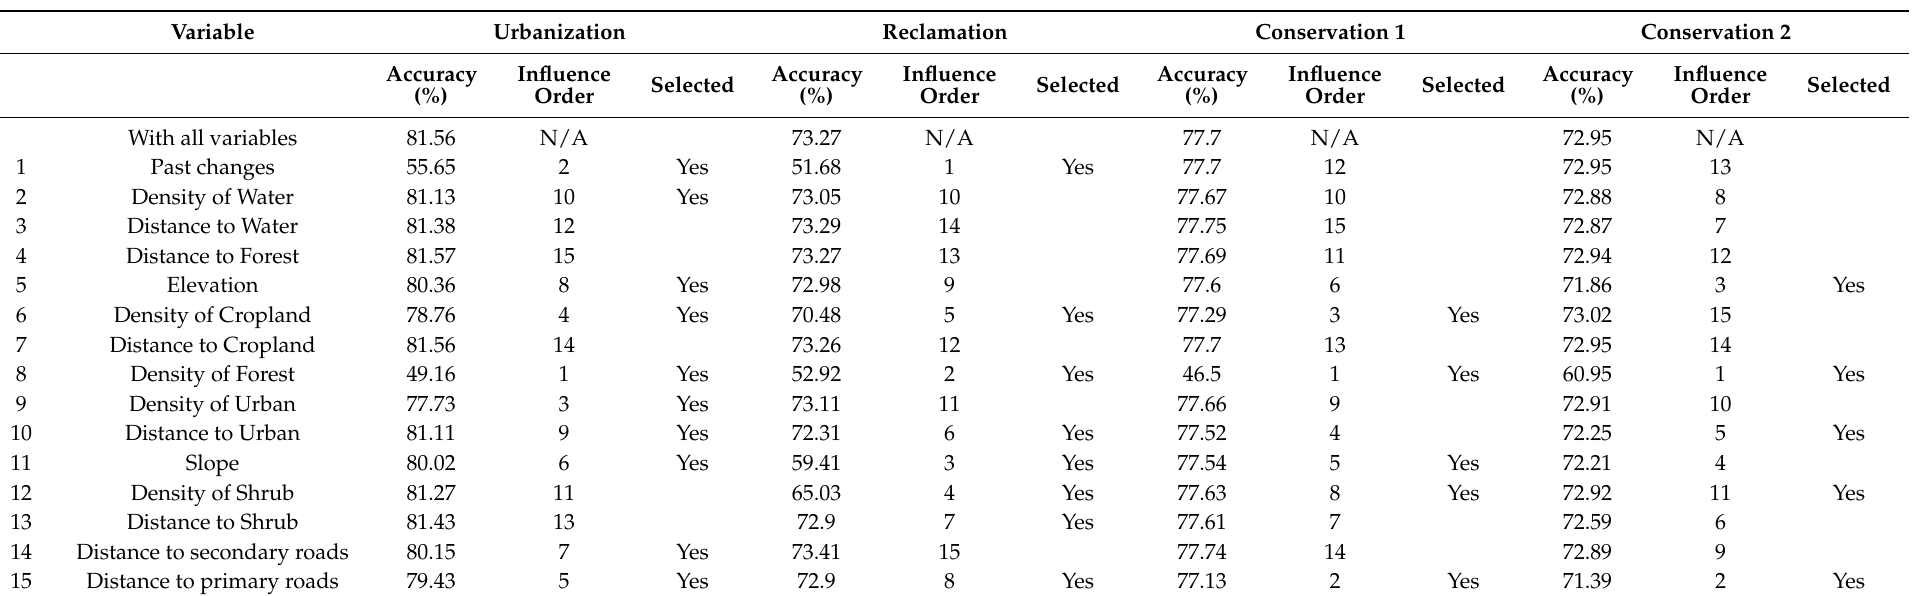
Table 7. Explanatory power of variables in sub-models and the ultimate selection for